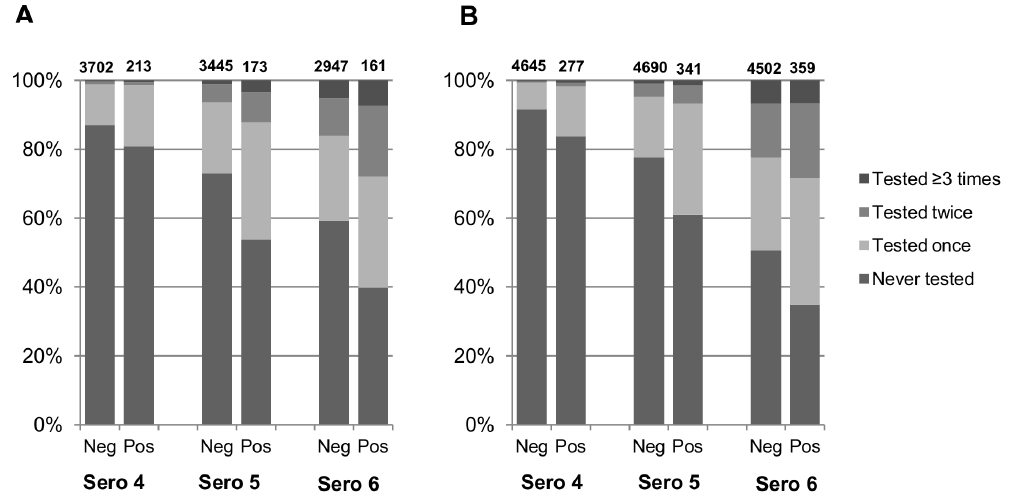
Figure 2. Number of times HCT was ever used (i.e. at sero-surveys and/or elsewhere) by the end of each sero-survey round by HIV status. Panel A) men; panel B) women. (NB: HIV status reflects status at the sero-survey round in question, rather than at any earlier test).